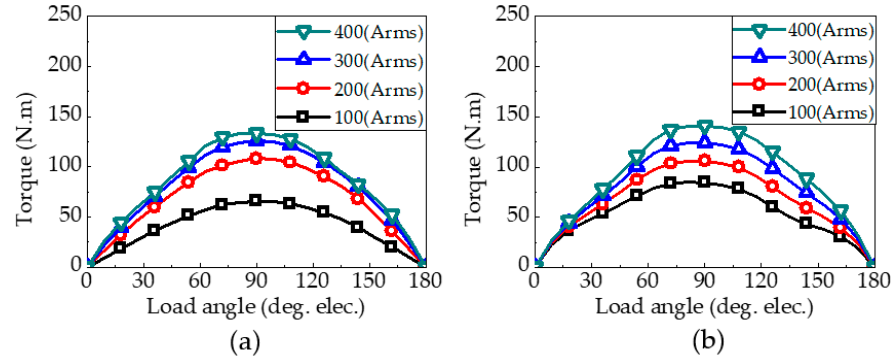
Figure 4. Pull-out torque curve according to the variation of the winding current: ( a ) Case of current variation of the inner winding with the rated current (168 A rms ) of outer winding; ( b ) Case of current variation of the outer winding with the rated current (424 A rms ) of inner winding.